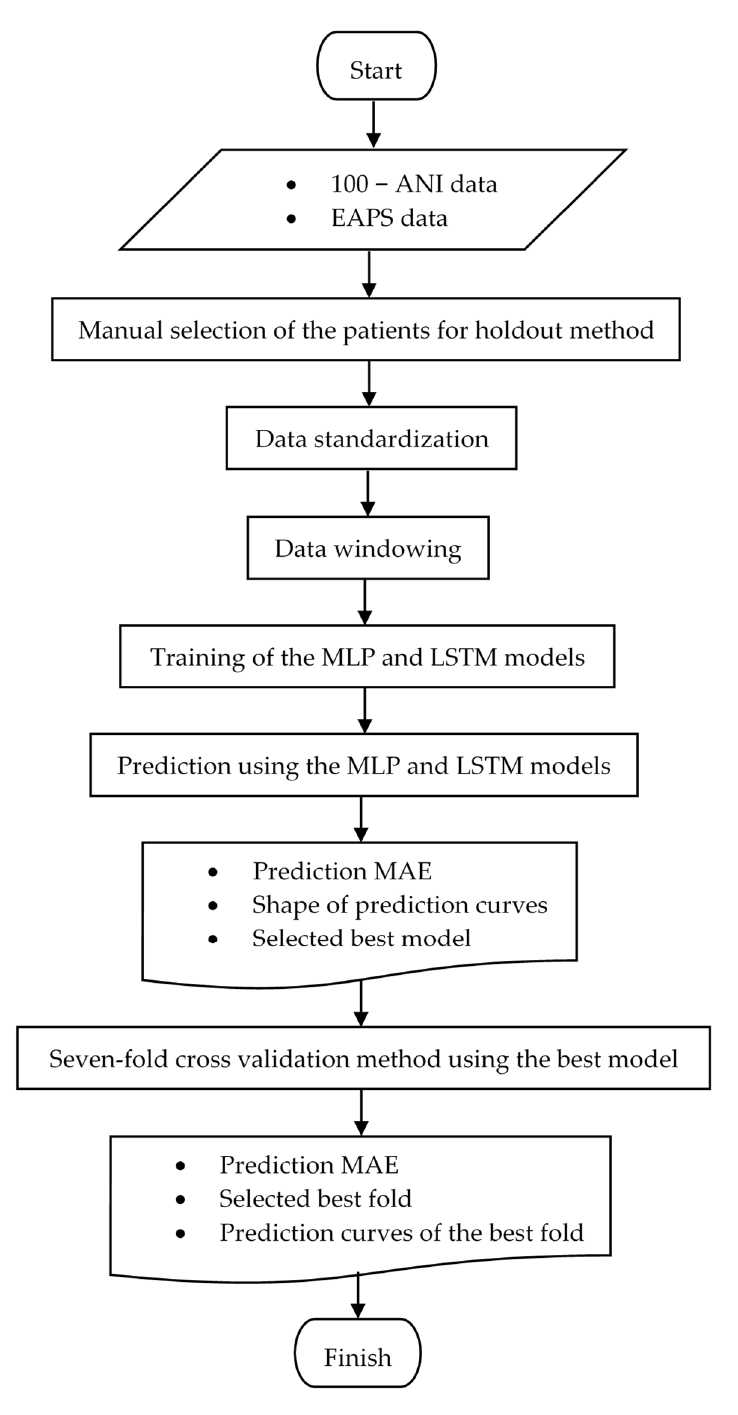
Figure 7. Flowchart of the deep learning model selection.